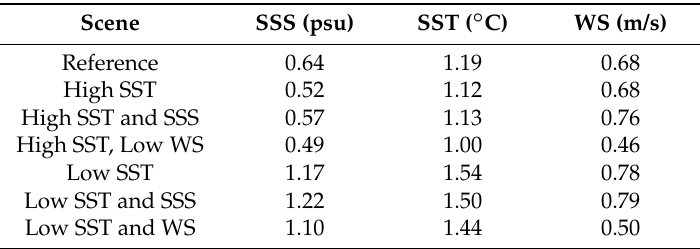
Table 4. The average errors of SSS, SST, and WS from 30 ◦ to 55 ◦ incident angles for the seven scenes in Table 3.